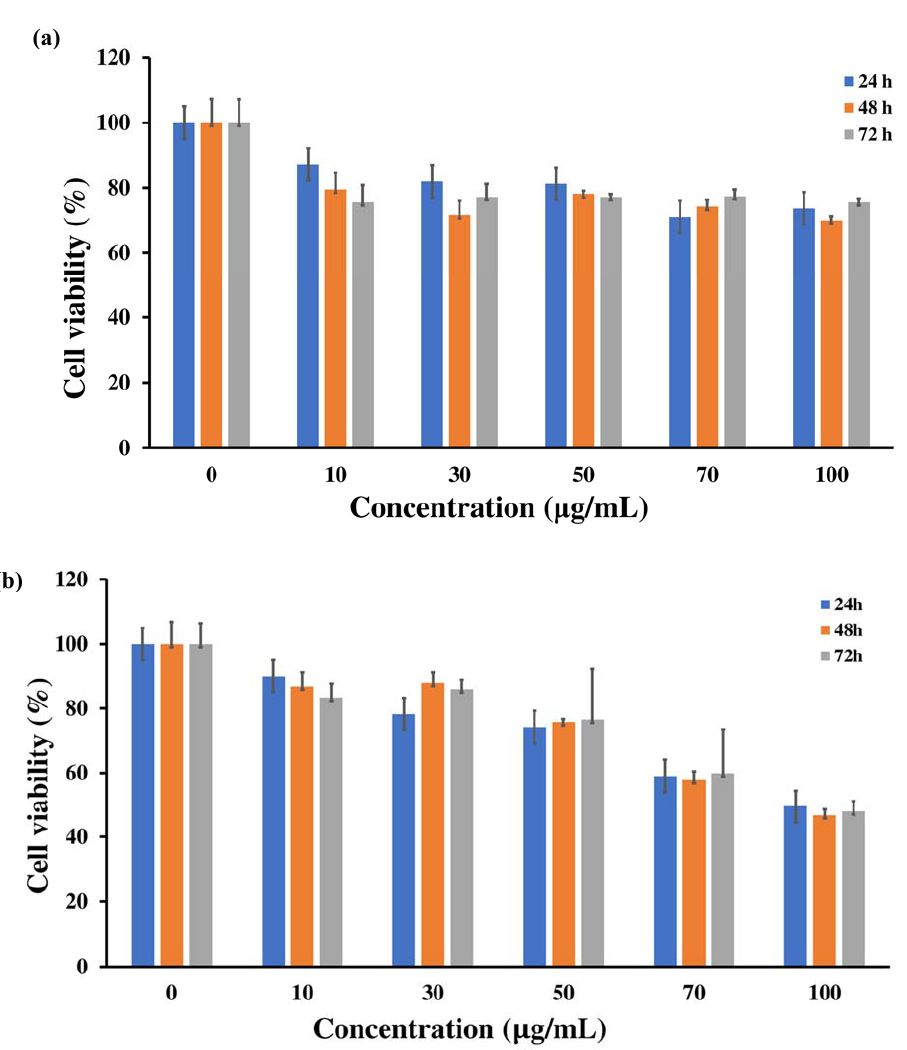
Figure 2. 3-[4,5- dimethylthiazol-2yl]-2,5-diphenyl tetrazolium bromide (MTT) assay of the ( a ) WS 2 sheets and ( b ) WS 2 / s-CoFe 2 O 4 @c-Fe 3 O 4 nanocomposites on bovine cornea endothelial cells for